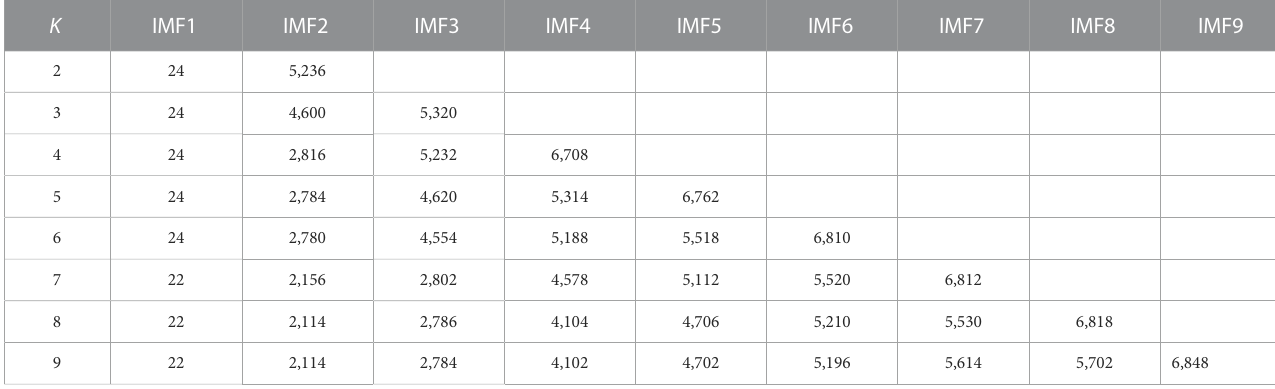
TABLE 3 Variation of center frequency for different K